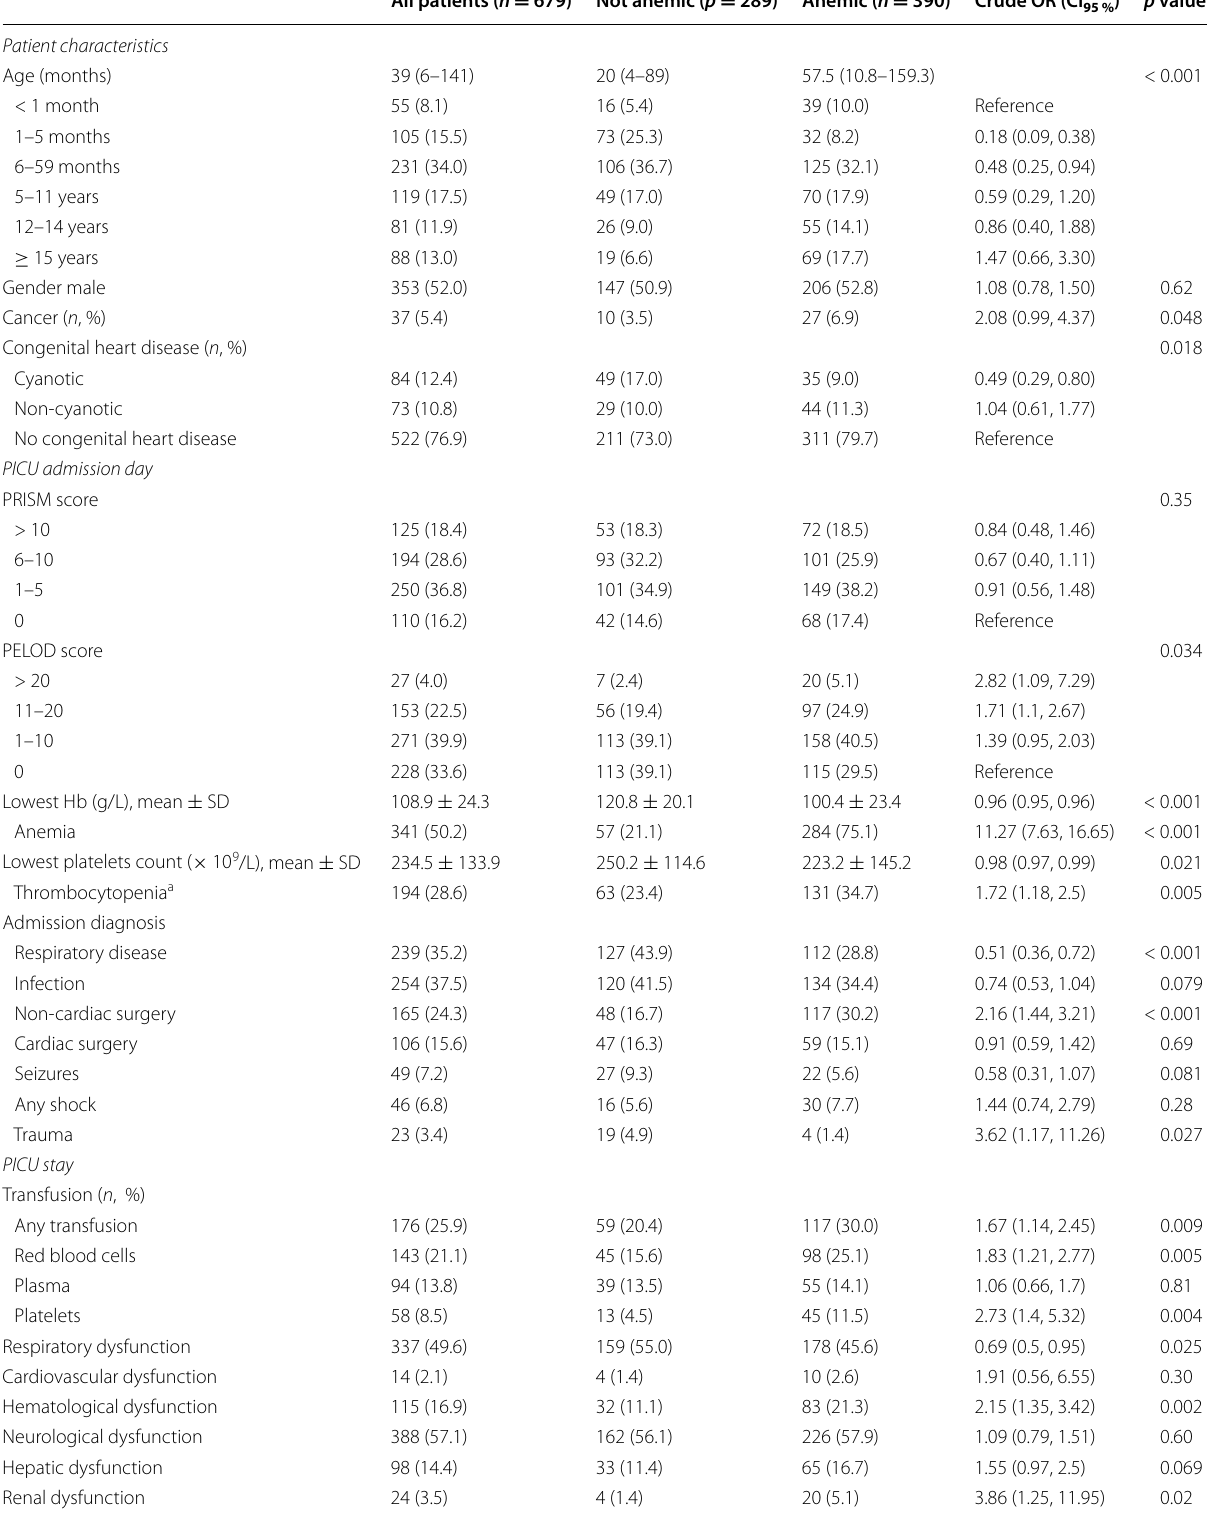
Table 2 Bivariate association between patient and PICU stay characteristics and anemia at PICU